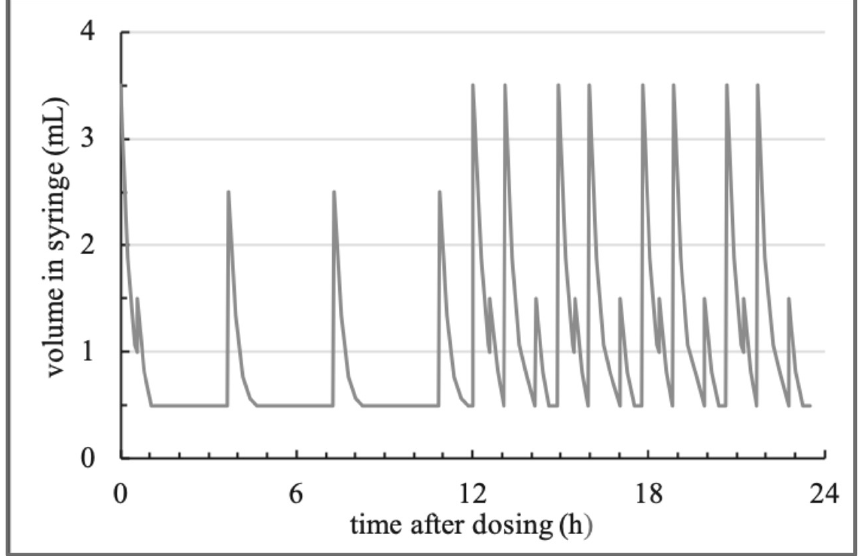
Figure 4. Volume in the syringe cavities over time.